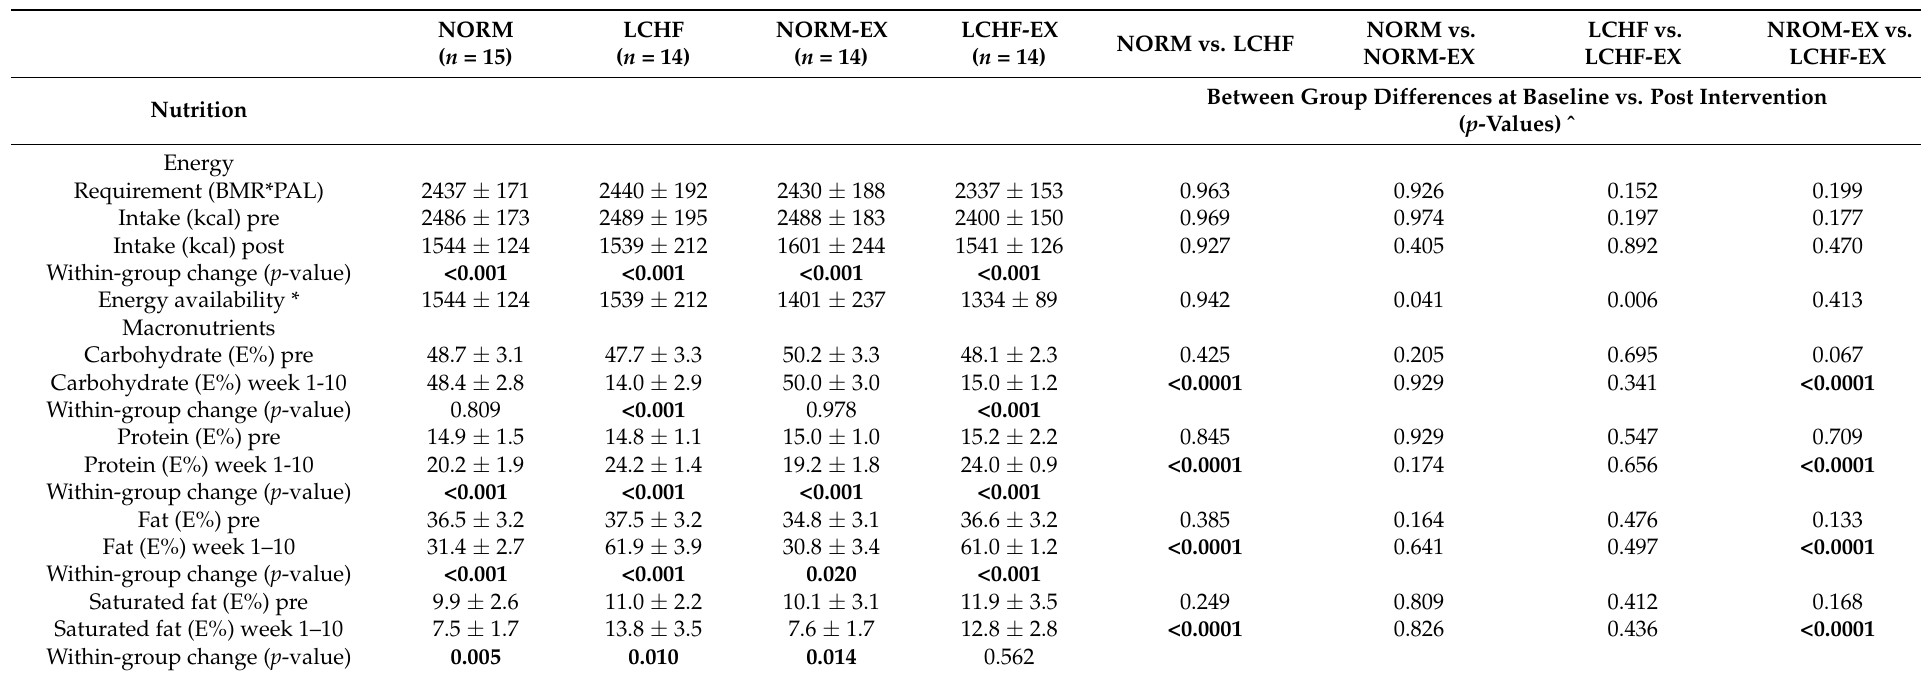
Table 4. Energy requirements, expenditure, intake and macronutrients at baseline and during the intervention.